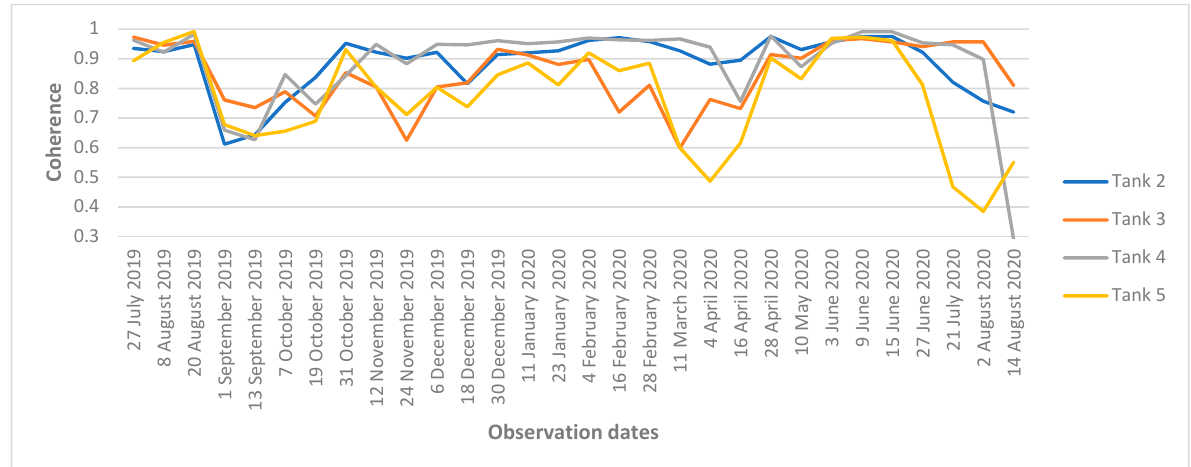
Figure 10. Interferometric coherence (no units) of tanks backscatter in 2019–2020. The plot of twelve-day interferometric phase differences is presented in Figure 11. The synchronicity in phase alterations is violated in the case of precipitation and freeze/thaw processes. Cold weather on 13 September, snowfalls in November–December, and snowmelt in April are also the cause for the divergence of the tank’s